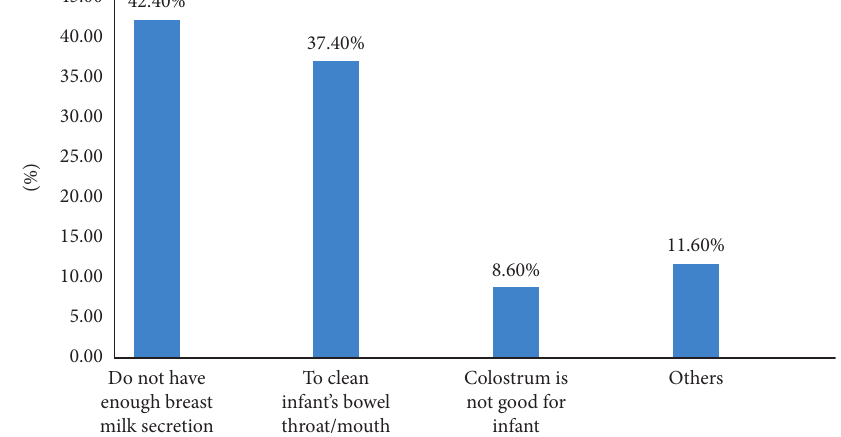
Figure 2: Reasons for practicing prelacteal feeding among mothers of children aged less than 12 months in the rural eastern zone, Tigray, Ethiopia, 2018.